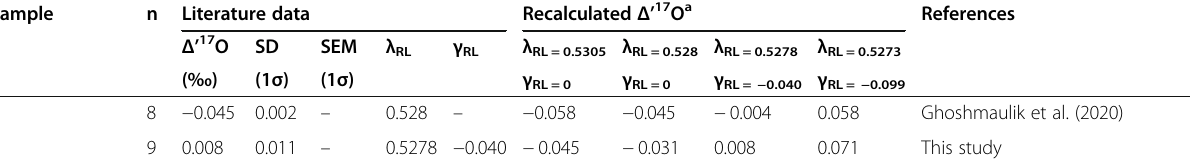
Table 4 Literature data of Δ 17 O and recalucalted Δ ’ 17 O relative to different assigned reference lines (Continued)